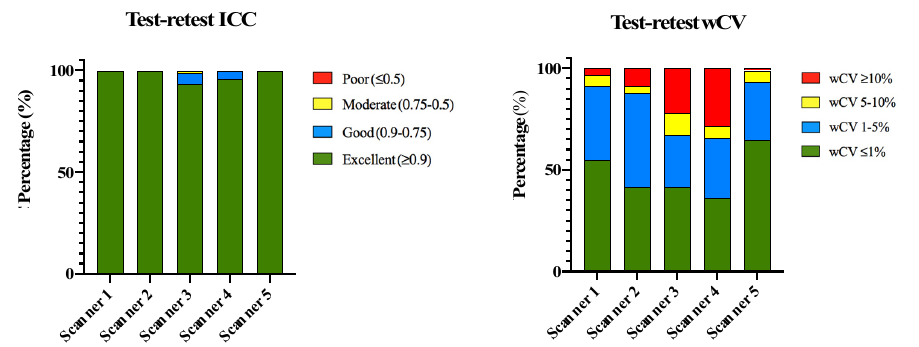
Figure 2. ICC and wCV histograms for the test–retest analysis of the radiomic features for the five CT scanners using protocol 1. Table 3. Interclass correlation coefficient (ICC) and within-subject coefficient of variation (wCV) values classified for the 91 radiomic features computed. Repeatability analysis was performed over the five CT scanners using protocol 1 of each machine. Test and retest acquisitions were obtained consecutively and without